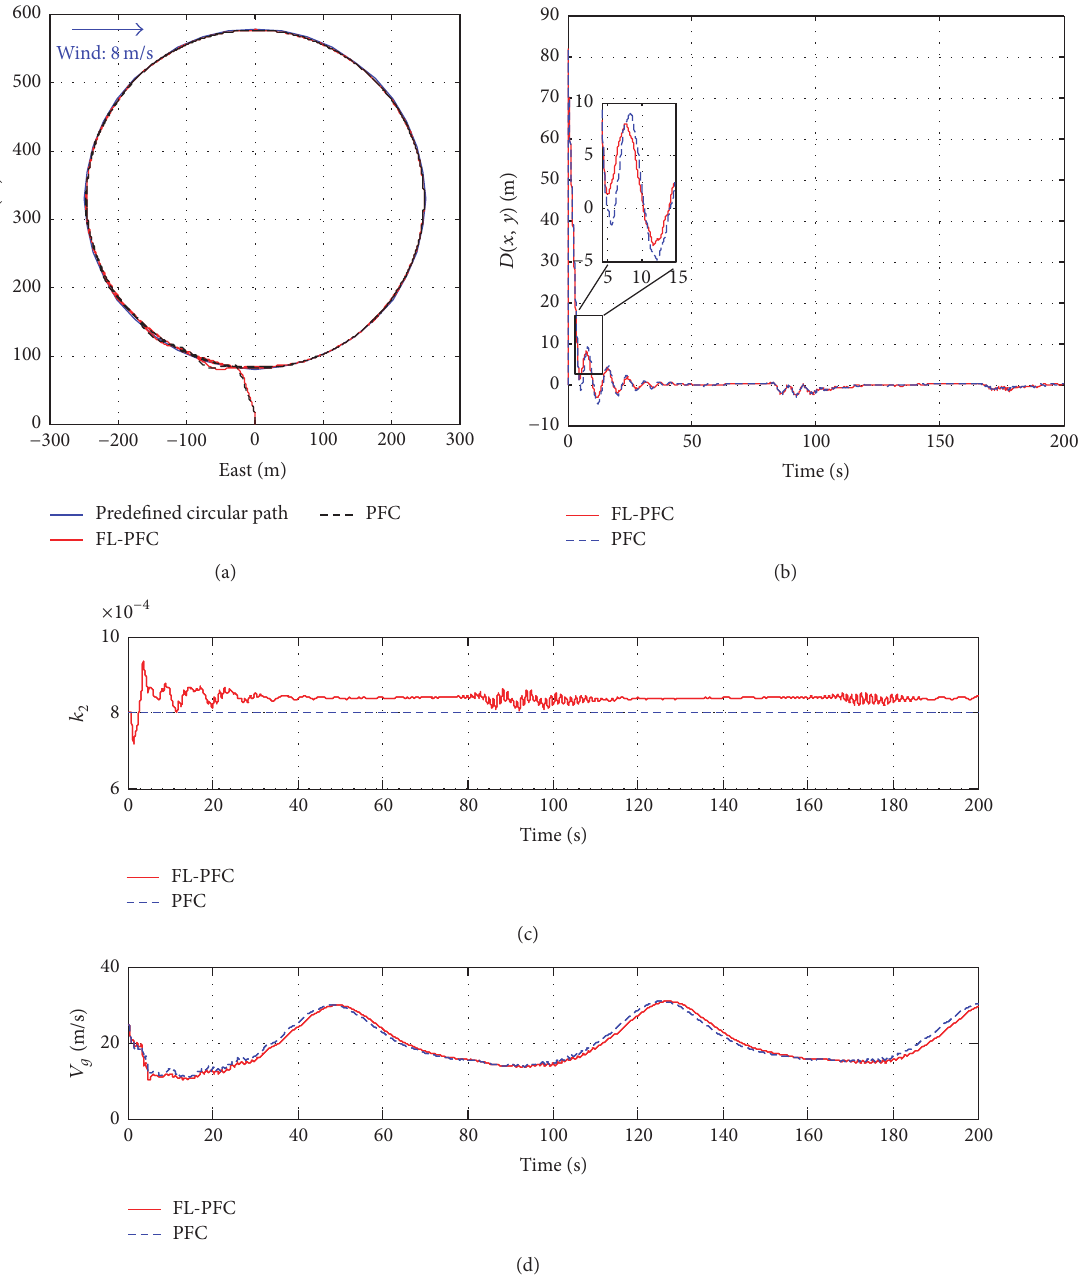
Figure 8: Comparison of the circular path following with the methods FL_PFC and PFC. (a) The position compassion, (b) the distance 𝑑(𝑥,𝑦) compassion, (c) the parameter 𝑘 𝑉 2 compassion, and (d) the inertial velocity 𝑔